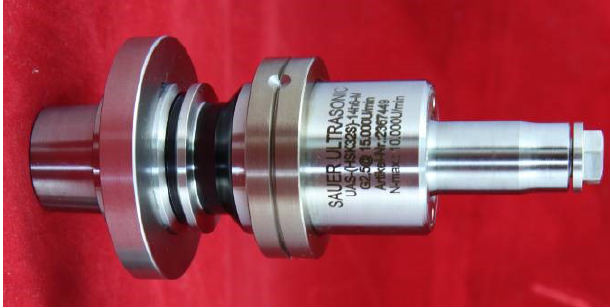
Figure 3. The 14h6 ultrasonic tool